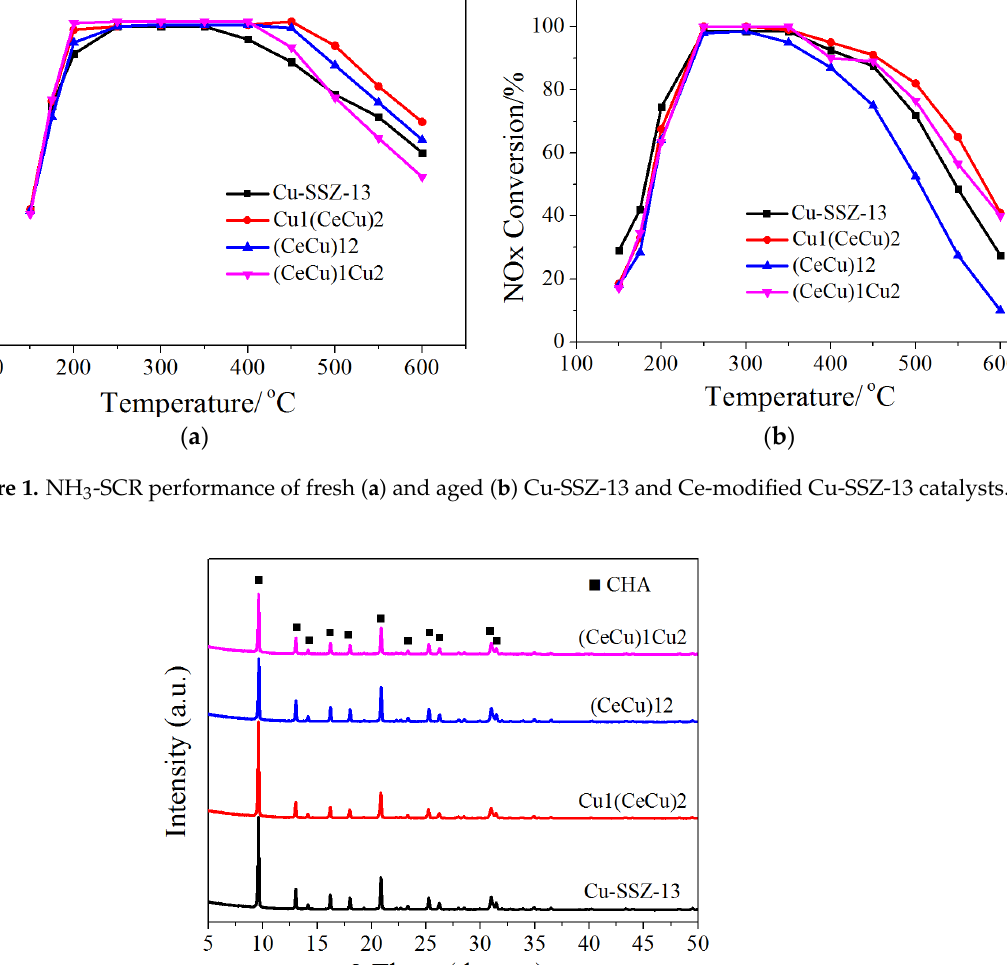
Figure 1. NH 3 -SCR performance of fresh ( a ) and aged ( b ) Cu-SSZ-13 and Ce-modified Cu-SSZ-13 catalysts.